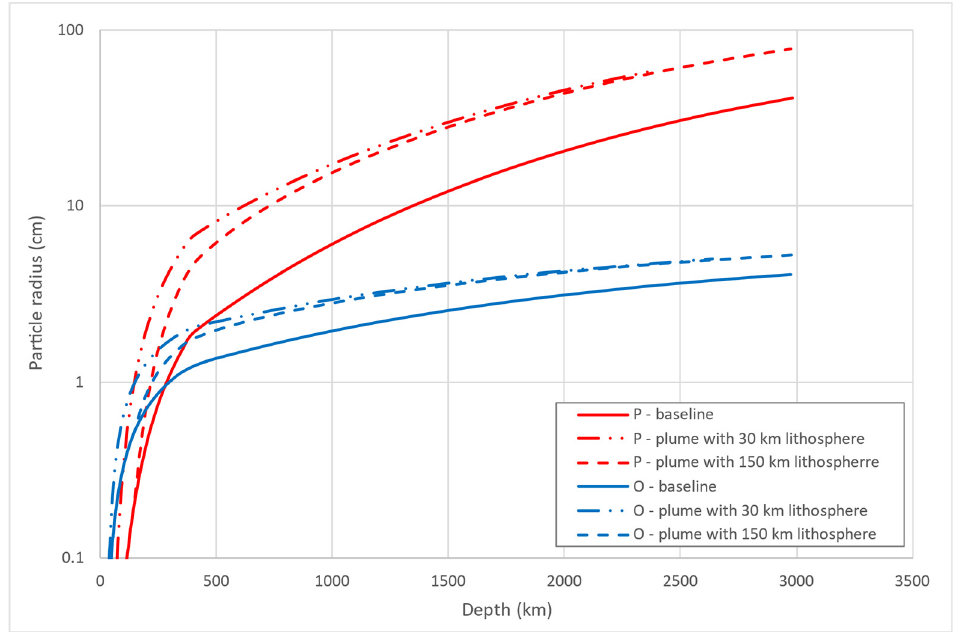
Figure 1. Solid pieces of iron can only be transported substantially unaltered to the surface from the deep mantle by a mantle plume if they are >1 cm radius. X -axis: depth (km). Y -axis: minimum radius for a sphere of iron to be transported from that depth to the surface, while losing no more than 50% of their phosphorus to diffusion. Plots show the temperature profile of the lithosphere, or that of a plume 300 °C hotter than the surrounding mantle [33], pooling below a 30 km [39] or a 150 km [40] thick lithosphere. Red lines show the required radius for the internal phosphorus concentration to be reduced by 50%; blue lines show the radius for the internal oxygen concentration to reach 50% of the external concentration.